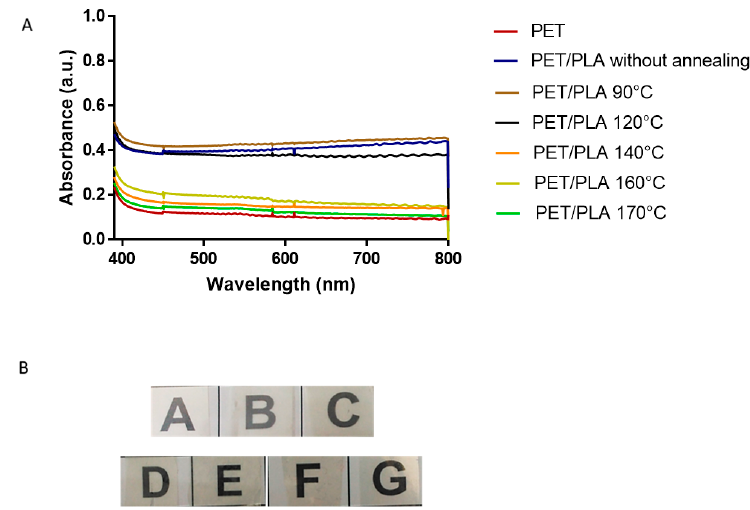
Figure 4. ( A ) Ultraviolet-visible (UV-Vis) transparency measures of the uncoated polyethylene terephthalate (PET) film and coated with electrospun polylactide (PLA) fibers at different